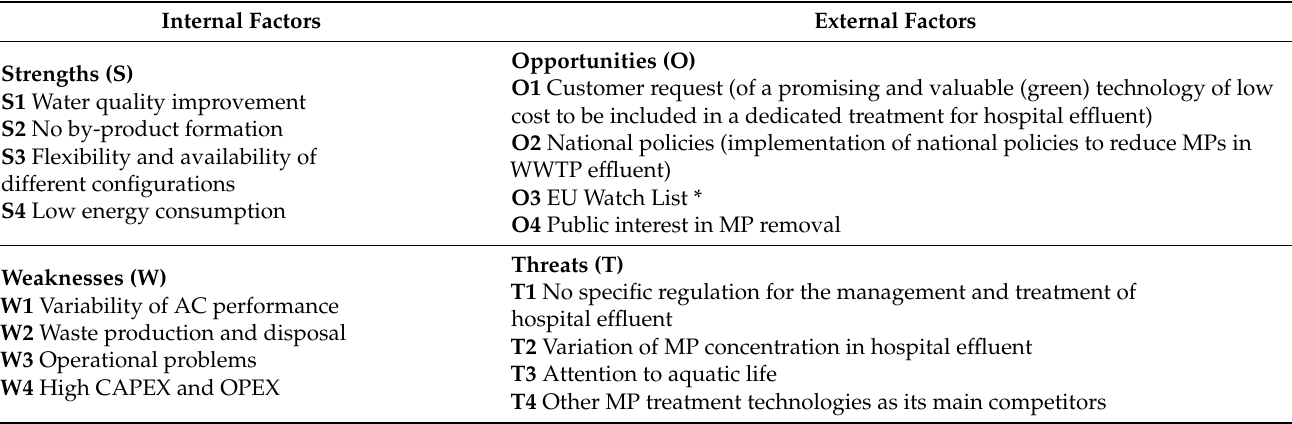
Table 3. SWOT matrix for AC technology.